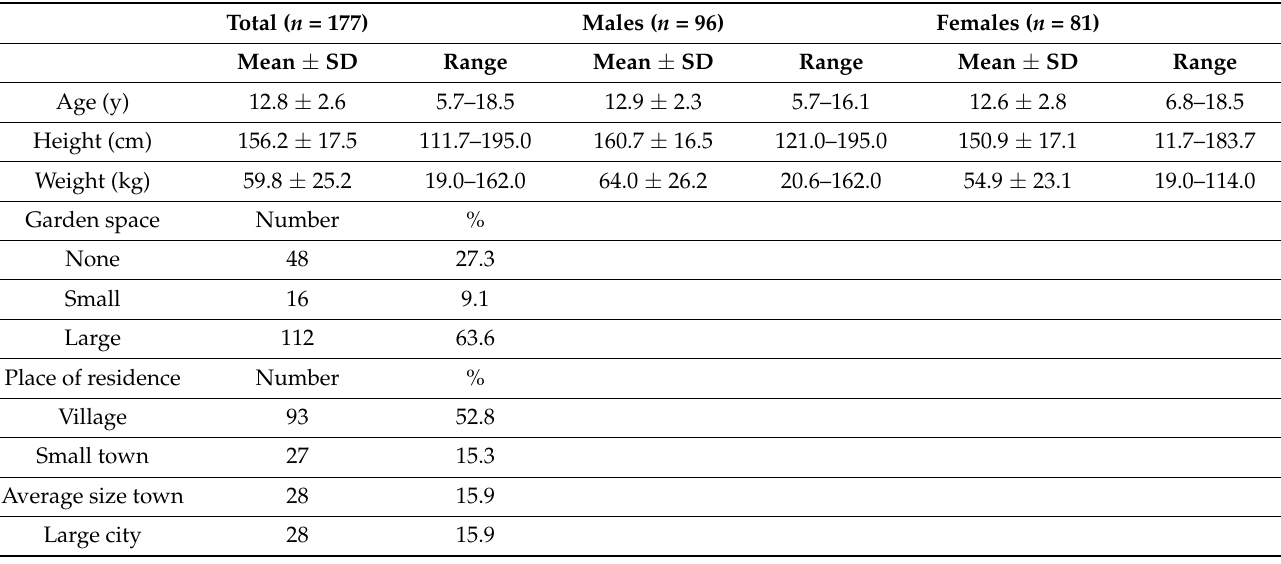
Table 2. Anthropometric data, the purpose of the visit in outpatient and residential characteristics during the